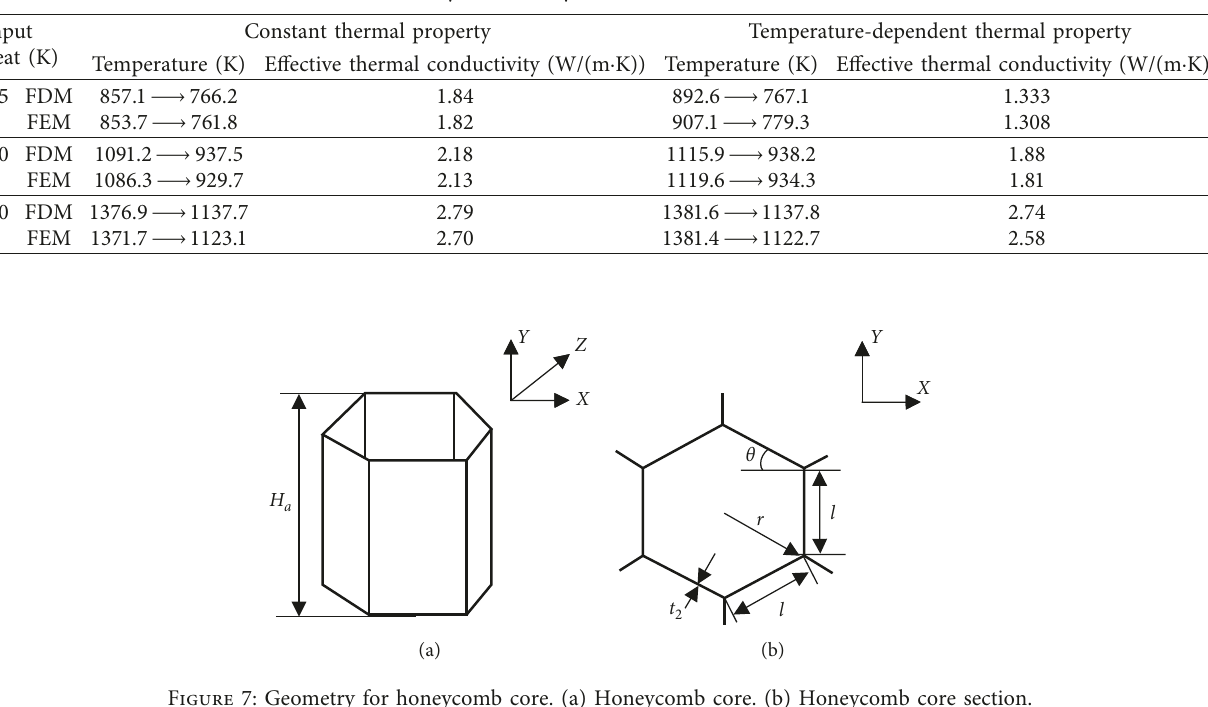
Table 3: Effective thermal conductivity obtained by the finite differential method and finite element method.